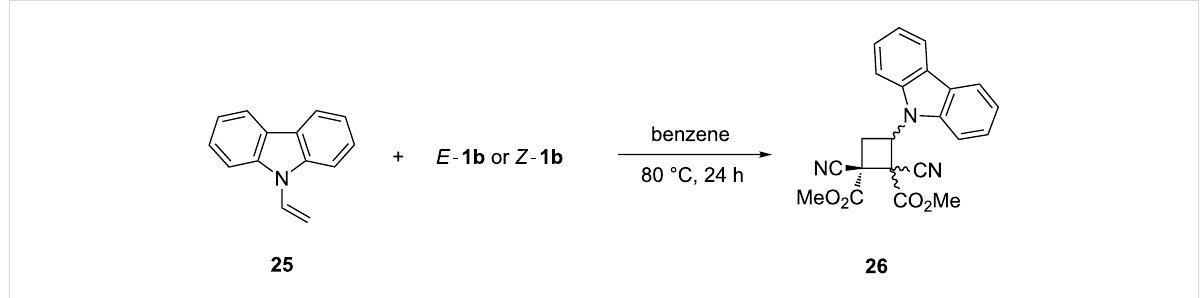
Scheme 7: The [2 + 2]-cycloaddition of isomeric dimethyl dicyanofumarate ( E - 1b ) and dicyanomaleate ( Z - 1b ) with N -vinylcarbazole ( 25 ).